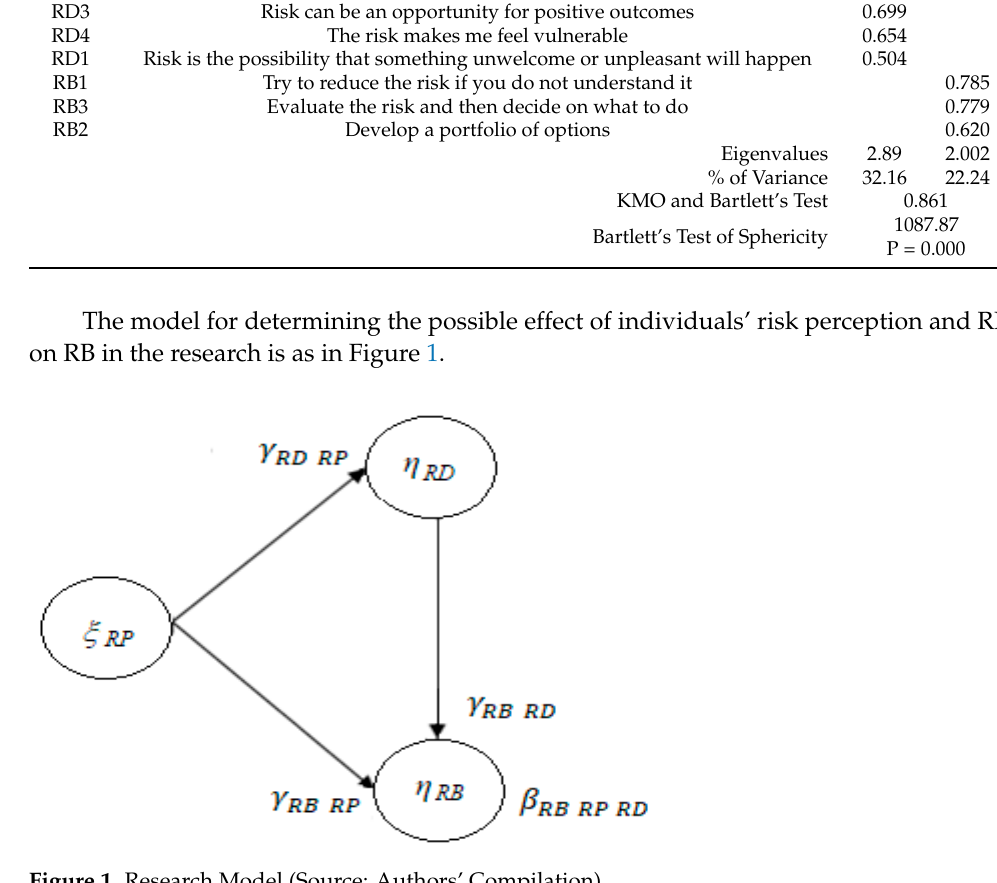
Figure 1. Research Model (Source: Authors’ Compilation).